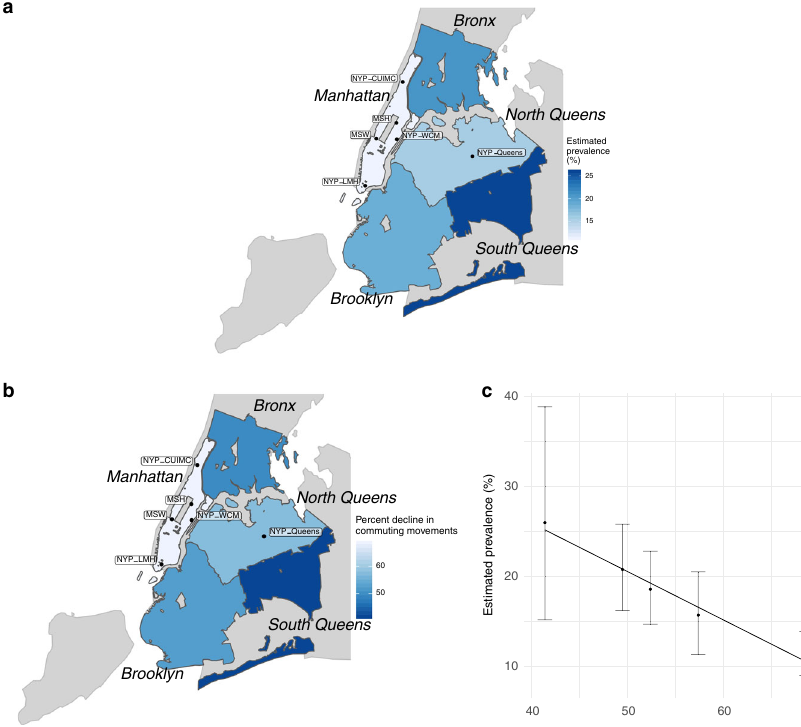
Fig. 2 SARS-CoV-2 prevalence is lower in boroughs with greater declines in commuting movements. a Estimated mean prevalence of SARS-CoV-2 infection by borough assuming a test with perfect speci fi city and 90% sensitivity. b Percent decline in commuting movements by borough during the study period compared to the 45 days preceding 26 Feb 2020. Commuting is measured as the total number of morning transits out of each borough and evening transits into each borough. Note the reverse scale, so that deep blue corresponds to higher prevalence in a and to a smaller decline in commuting in b . c Relationship between estimated prevalence of SARS-CoV-2 infection and decline in commuting movements by borough (Pearson R = − 0.88, [ − 0.52, − 0.99]). Points depict the mean posterior prevalence for each borough as a function of percent decline in commuting movements and error bars represent 95% credible intervals for the posterior prevalence distributions. Sample sizes are as follows: Bronx, n = 309; Brooklyn, n = 386; Manhattan, n = 718; North Queens, n = 275; South Queens, n = 58 tests. New York NYP — CUIMC Presbyterian Columbia University Irving Medical Center, NYP — WCM Weill Cornell Medical Center, NYP — LMH Lower Manhattan Hospital, NYP — Queens Queens Hospital, MSH Mount Sinai Hospital, MSW Mount Sinai West. Source data are listed in Supplementary Tables 3 and 4, and provided as a Source Data fi